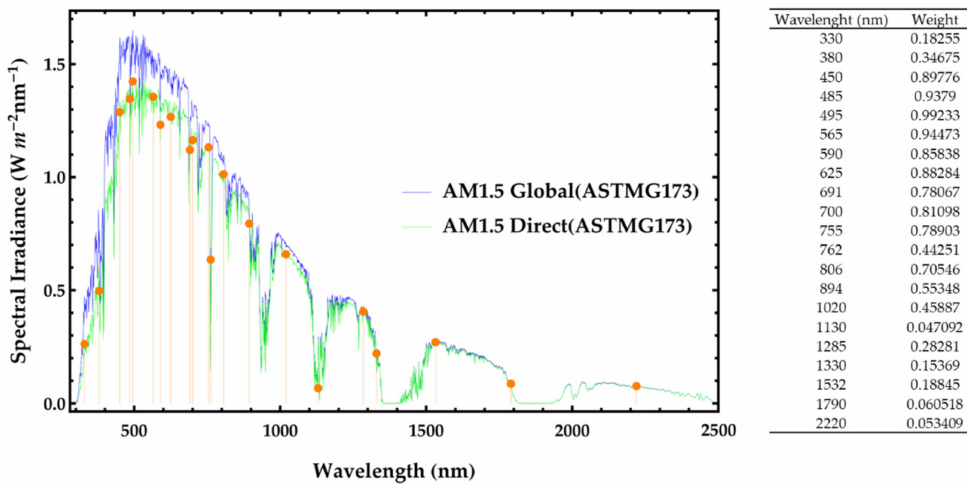
Figure 8. Global and direct solar spectra ASTMG173 at AM1.5, with the selected wavelength used for ray tracing in Zemax and its respective weight